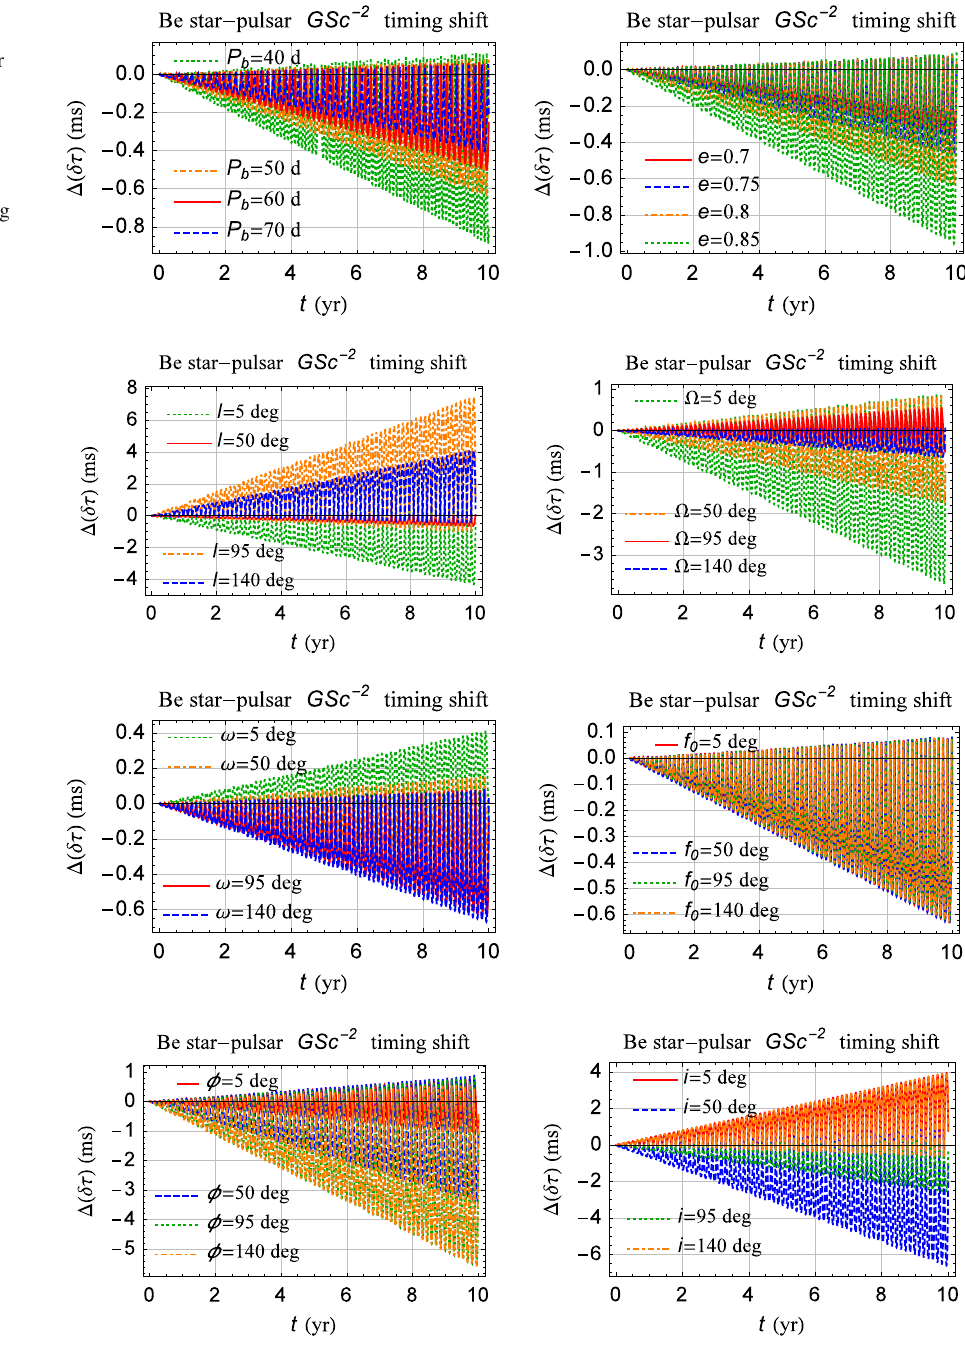
Fig. 4 Numerically integrated time series of the timing shift (cid:4)(δ τ ) due to Eq. (7), in ms, for variations of the parameter space of a fictitious binary pulsar, characterized by P b = 50 days , e = 0 . 8 , I = 50 deg , (cid:12) = 140 deg , ω = 149 deg , f 0 = 228 deg, orbiting a Be-type star with M = 15 M (cid:2) , S